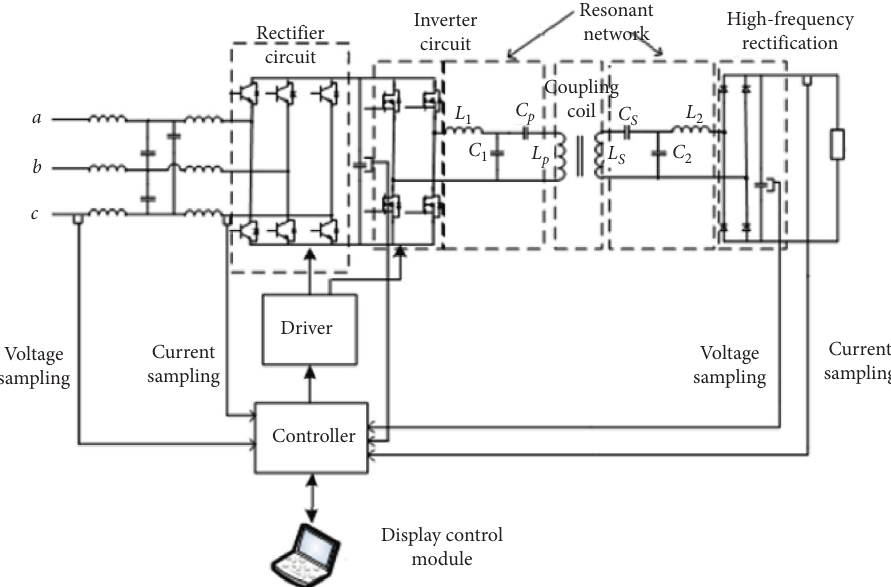
Figure 11: Underwater ICPT